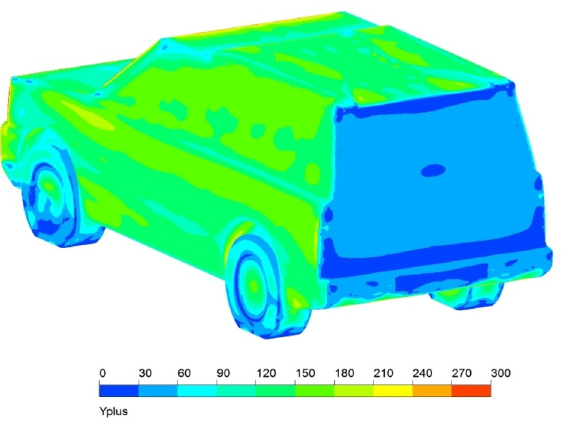
Figure 9. y + on the modified roof model